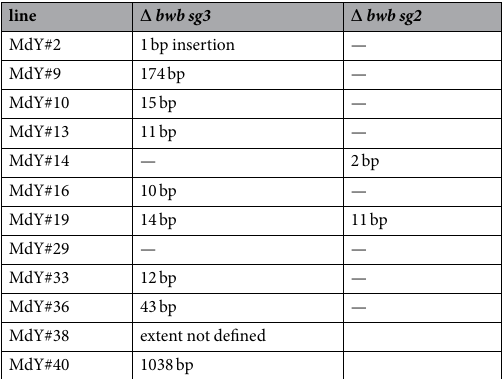
Table 2. Overview of MdY lesions in bwb males. 12 CRISPR lines are listed with lesions detected in the target sites, ∆ bwb sg3 and ∆ bwb sg2. The majority of mutations caused by NHEJ occurred in the ∆ bwb sg3 region ranging in size from 1 bp insertion to1038 bp deletions. In line MdY#38 sequence changes in and downstream of ∆ bwb sg3 but we were unable to determine the extent of this putative lesion (extent not defined). In line MdY#29 none of the isolated subclones harbored a visible lesion in the region of the two target sites. Since it produced recombinant pw , bwb + females, it is likely that the pw + , bwb males are products from a recombinant event rather than from a NJEH induced